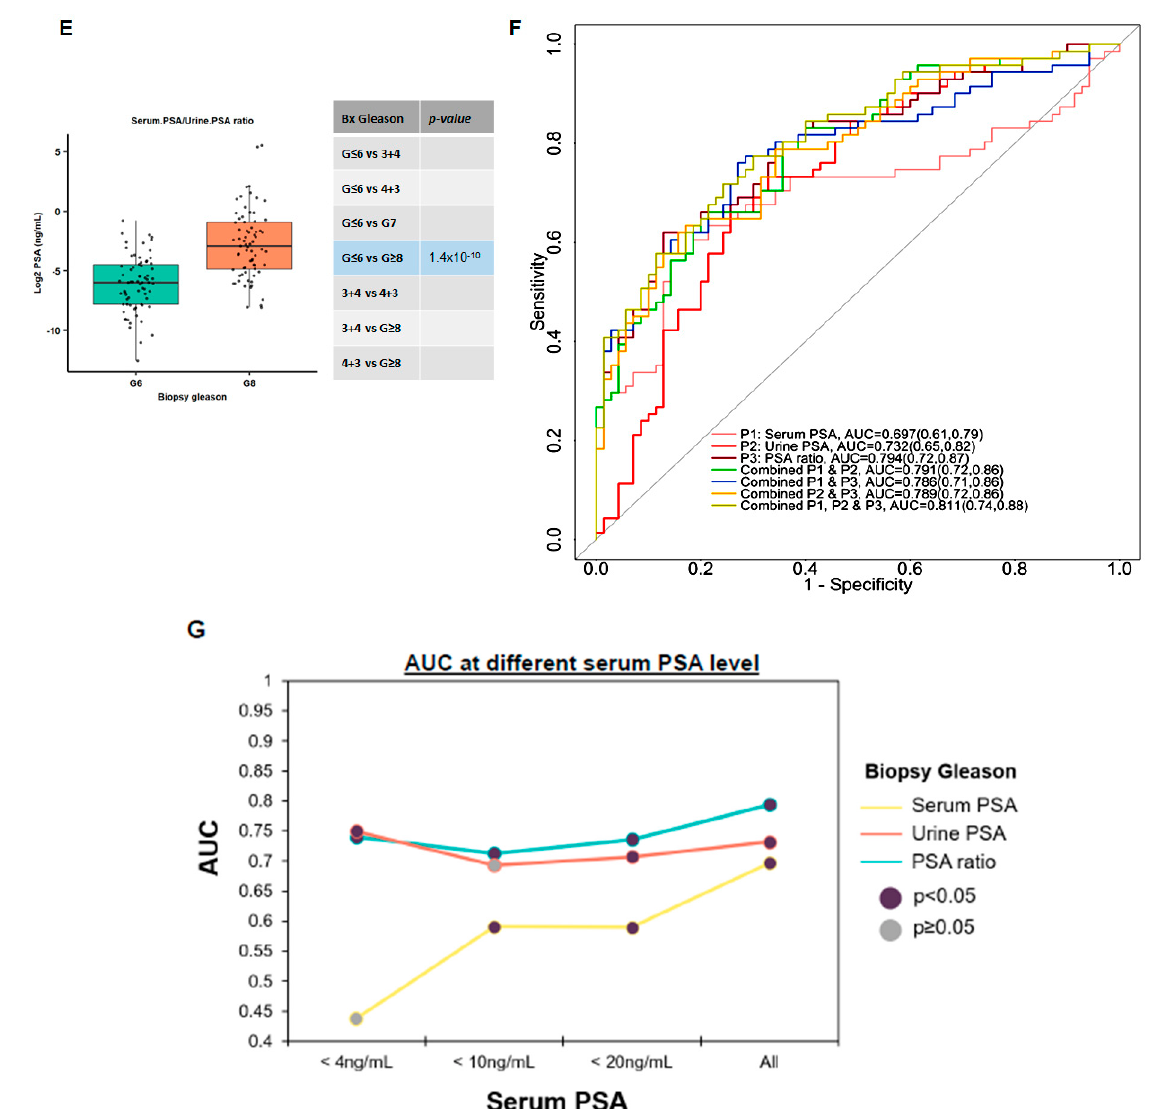
Figure 3. Utilizing urine and serum PSA ratio in differentiating AG from NAG. The two-dimensional plots with ellipse ( A ) and without ellipse ( B ) show the overall distribution of PSA values in urine and serum samples in the (n = 141) cohort 1 for GS ≤ 6 vs. GS ≥ 8 samples. The red dot represents the center distribution point for all the PSA values. The Log 2 values for serum PSA are shown on the y -axis, and urine PSA values are given on the x -axis ( A,B ). The median values of serum PSA ( C ) and urine PSA ( D ) or their ratios ( E ) in the AG vs. NAG patients were plotted to show the distribution of individual values of PSA. The p values for each group are given on each side of the plot. Significance was set at p < 0.05. The ROC curve between serum (P1) and urine (P2) or the ratios of serum to urine (P3), as well as the combinations of serum and urine along with the ratios, demonstrate the utility of serum to urine PSA. Numbers in parentheses represent the 95% (CI) confidence intervals ( F ). The performance of urine PSA and PSA ratio at different serum PSA levels were investigated using only the samples with serum PSA levels below the cutoff (4 ng/mL, < 10 ng/mL, <20 ng/mL). The AUCs obtained from using all the samples, regardless of serum PSA level, were included in the plot (i.e., All) as well. The p -values were from comparing a marker against the null of AUC = 0.5 ( G ).